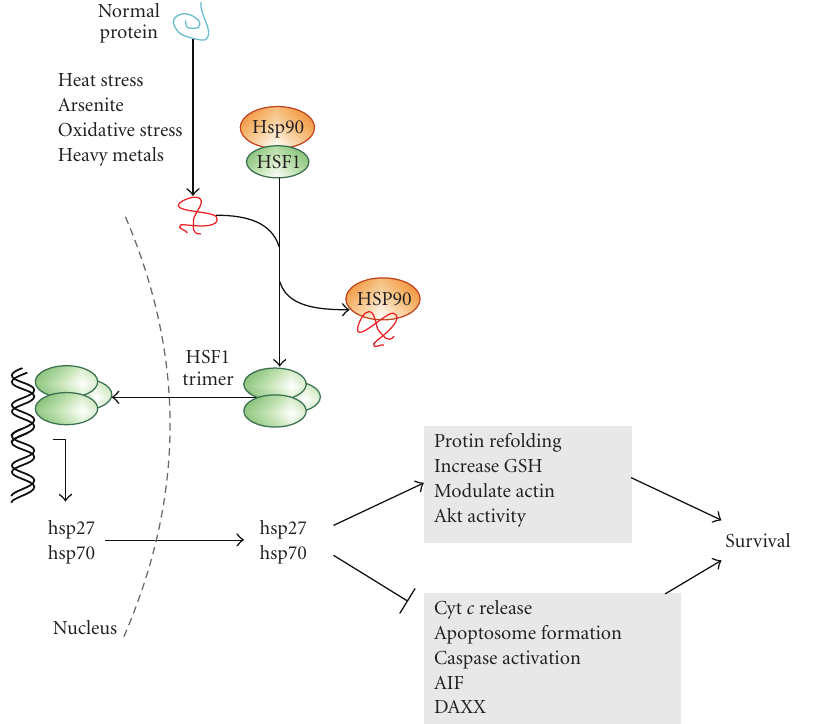
Figure 1: Induction of heat shock proteins inhibits apoptosis and promotes cell survival. Exposure of cells to elevated temperatures, oxidative stress, and heavy metals causes accumulation of unfolded proteins, which through activation of HSF1 leads to induction of Hsp27 and Hsp70. These Hsps inhibit apoptosis and promote